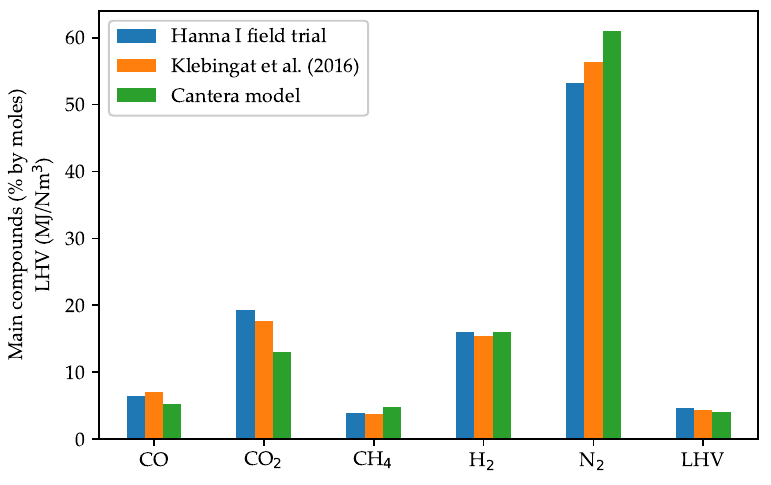
Figure 7. Comparison of our simulation results (T = 600 ◦ C, p = 0.48 MPa, stoichiometric ratio = 0.12) against the Hanna I experiment field data [60] and the thermodynamic modeling results of Klebingat et al.